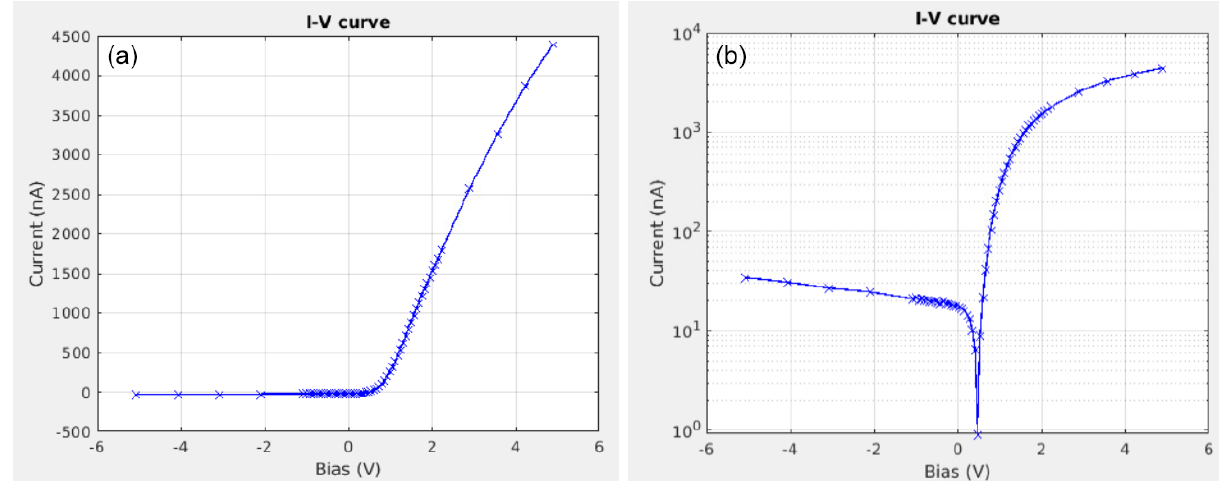
Figure 13. In-flight measured I-V characteristic with 60 data points acquired on 30 January 2021 at 13:03:59UTC. (a) Linear scale, (b) semi- logarithmic scale.